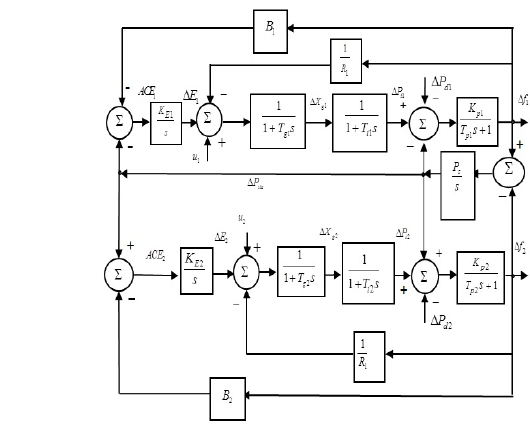
Fig. 1: Two control areas interconnected through a sin- gle tie line 1 − 1 ∆ ˙ P T 1 = ∆ X g 1 + ∆ P t T t 1 T t 1